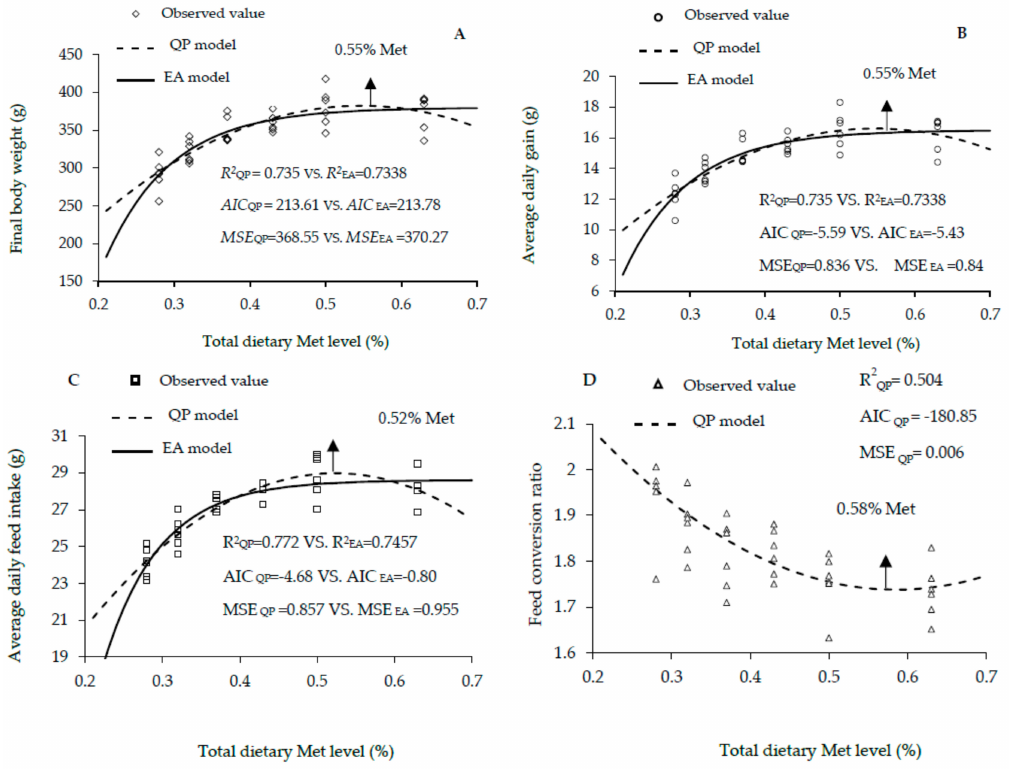
Figure 1. Regression models plot of growth performance as a function of total dietary Met level (0.28, 0.32%, 0.37%, 0.43%, 0.50%, and 0.63% Met) of male rapidly growing yellow-feathered chickens between 0 and 21 days of age. Correlation coe ffi cient ( R 2 ), Akaike information criteria (AIC), and mean squares error (MSE) are indicators for evaluating model fitness. ( A ) The optimum response arrow pointing at 0.55% Met by quadratic polynomial (QP) model. ( B ) The optimum response arrow pointing at 0.55% Met by QP model. ( C ) The optimum response arrow pointing at 0.52% Met by QP model. ( D ) The optimum response arrow pointing at 0.58% Met according to the QP